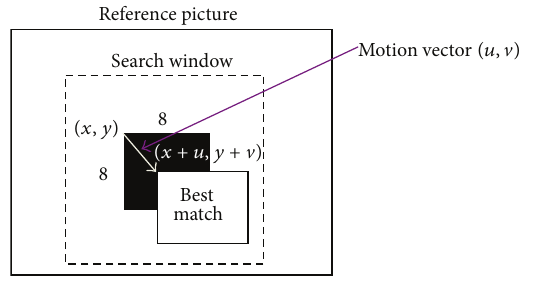
Figure 2: The best-matched reference block composes the motion